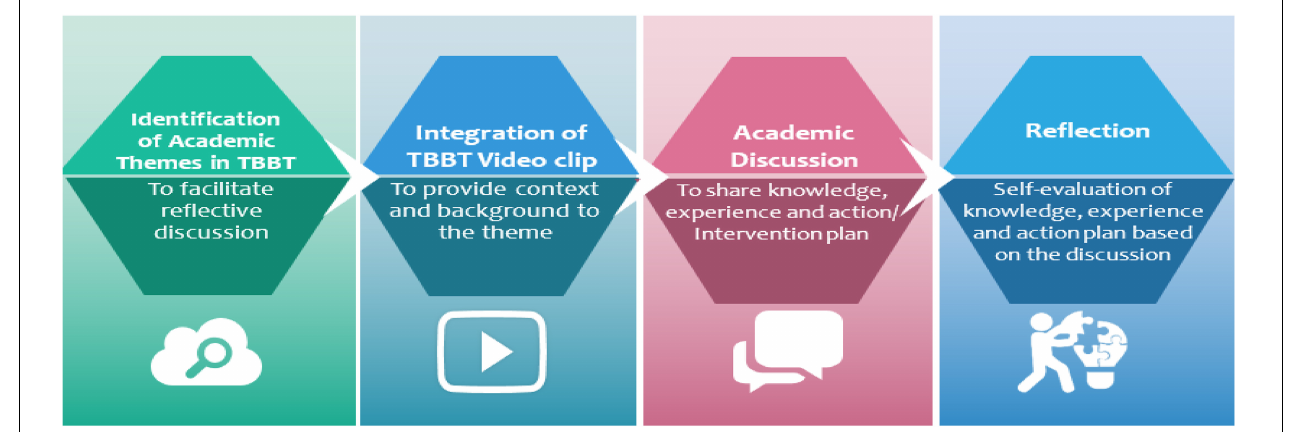
FIGURE 1 | Conceptual framework on the process of academic cultural competence